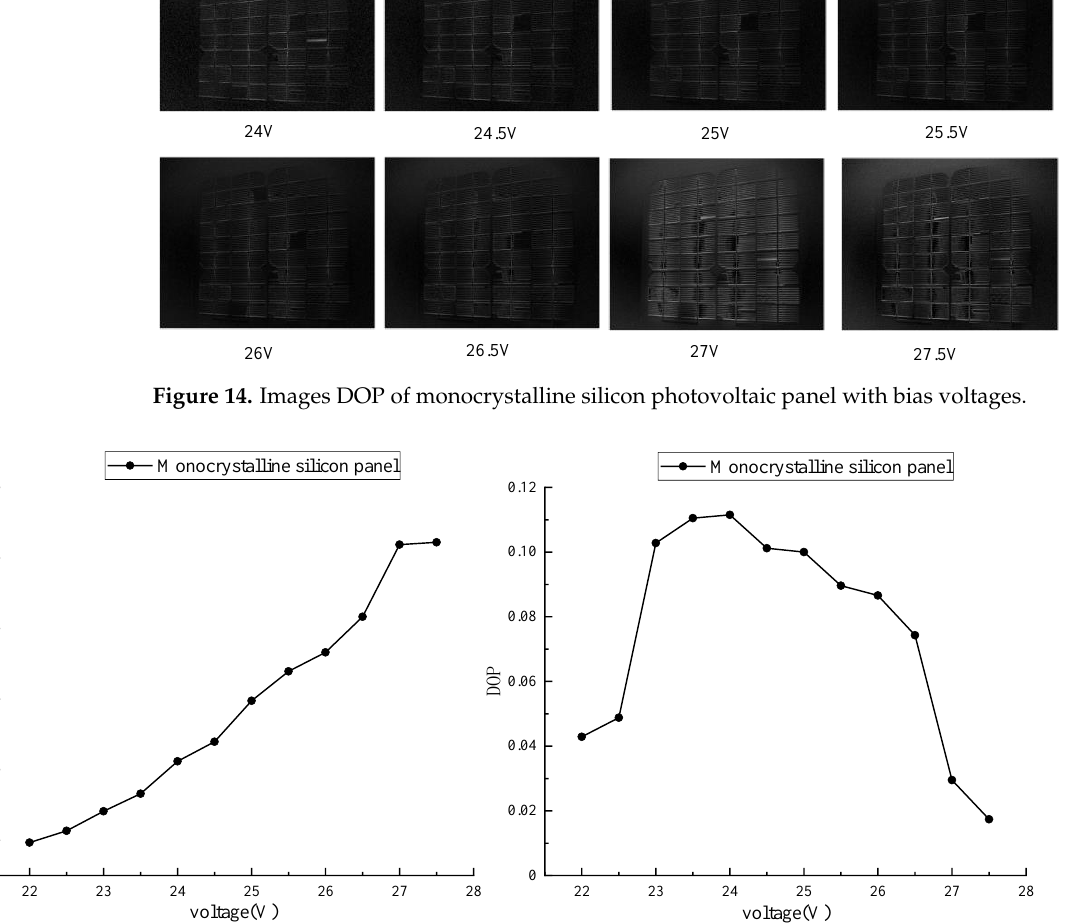
Figure 15. Diagram of monocrystalline silicon photovoltaic panel ( a ) electrolum inescence intensity of the photovoltaic panel with the forward bias voltage; ( b ) degree of polarization of the photovoltaic panel with the forward bias voltage.